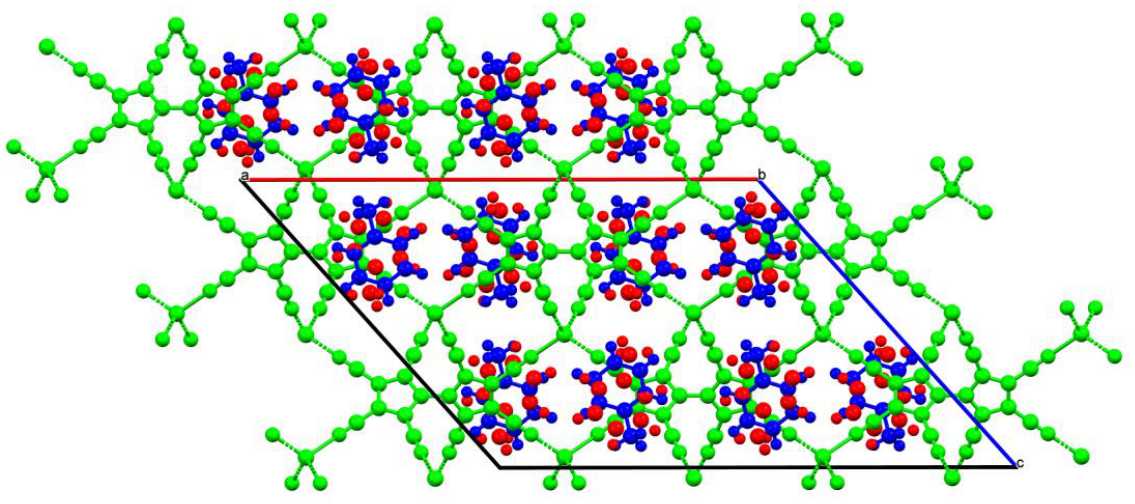
Figure 7. Packing plot ( MERCURY ) of compound 4 , watched along b . Color coding: green is the coordination polymer, while blue/red are the disordered toluene molecules.